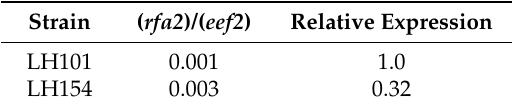
Table 3. Expression of rfa2 in suspected rfa2 deletion strain relative to the wild-type. Expression was normalized to eef2 expression.